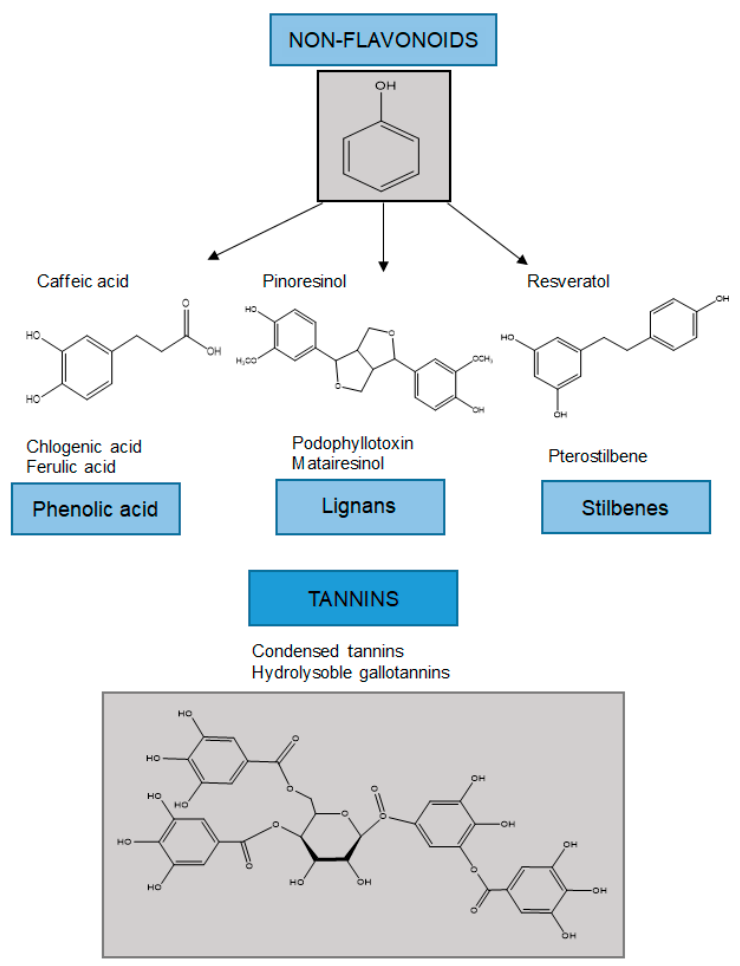
Figure 2. Classification of non-flavonoids and examples of their chemical